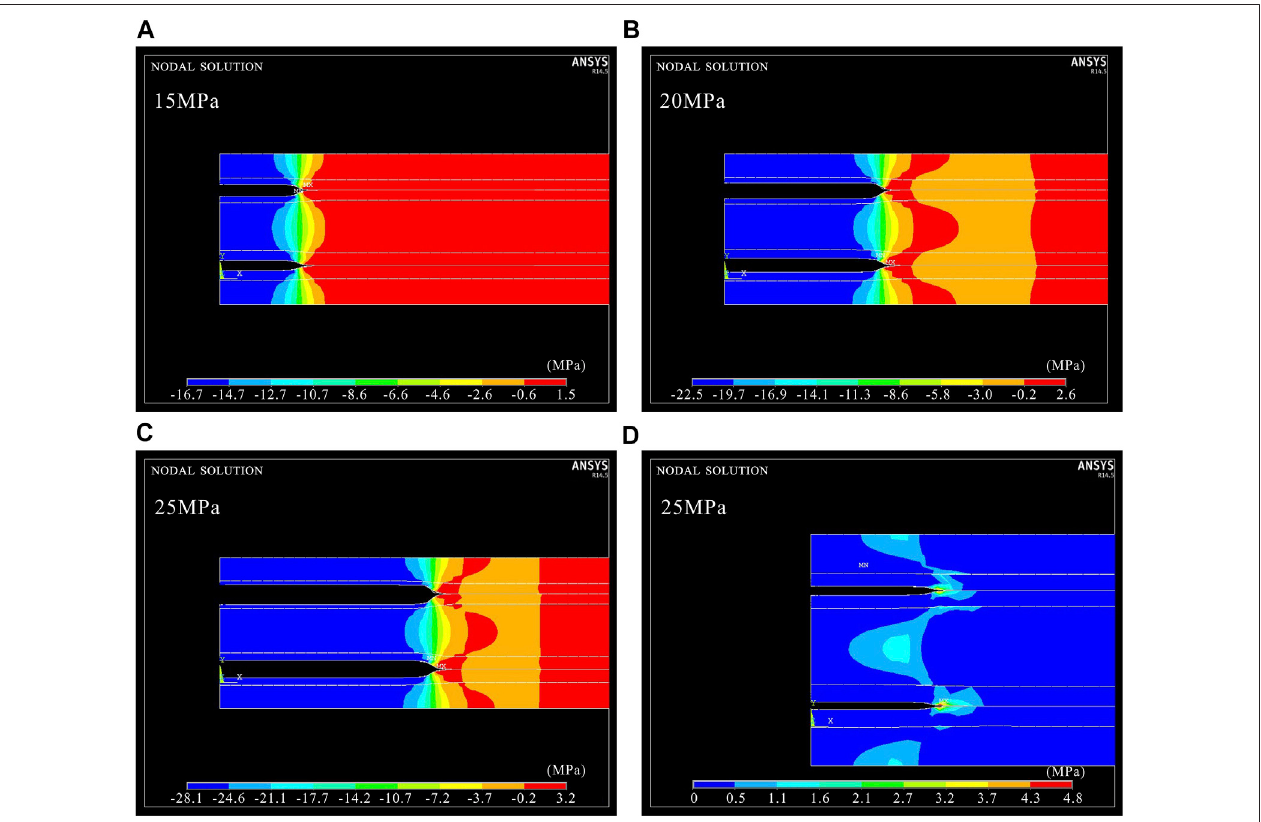
FIGURE 5 | The combined seam fracturing simulation result and the stress contour plot. (A) The stress contour plot along the Y -axis under a pressure of 15 MPa. (B) The stress contour plot along the Y -axis direction under a pressure of 20 MPa. (C) The stress contour plot along Y -axis under a pressure of 25 MPa. (D) The fi rst principal stress contour plot under a pressure of 25 MPa.